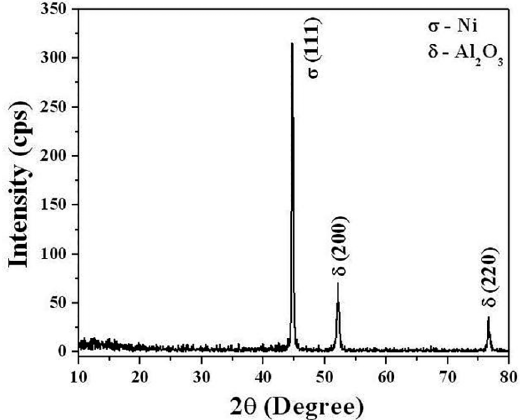
O composites of cast 2 3